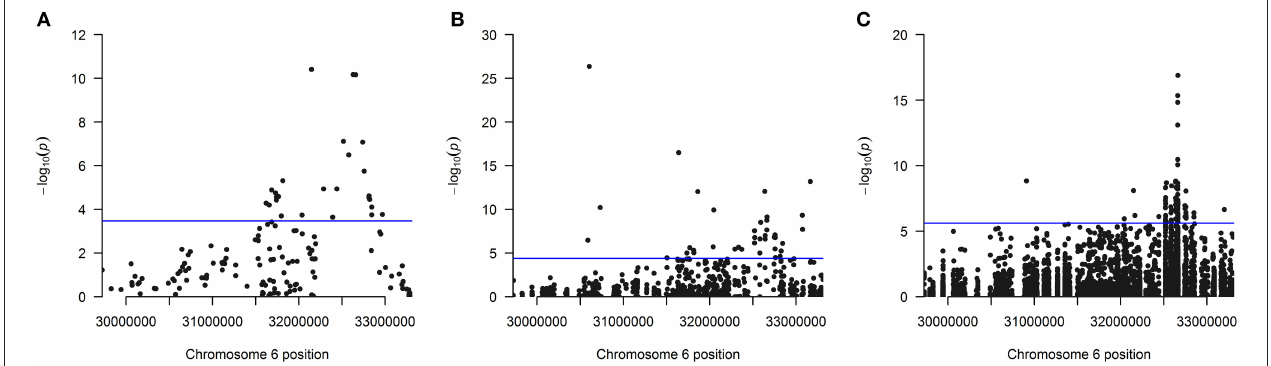
FIGURE 1 | (A) Manhattan plot of all 147 analyzed genes showing the position of the 26 genes found significantly associated after Bonferroni correction using the linear kernel SKAT test (see also Table 1 ). (B) Manhattan plot for all 1,209 analyzed exons showing the position of the 40 exons found significantly associated after Bonferroni correction using the linear kernel SKAT test (see also Table 2 ). (C) Manhattan plot for all 20,236 analyzed SNVs showing the position of the 92 SNVs found significantly associated after Bonferroni correction using logistic regression (see also Supplementary Table 6 ). The line indicates the significance cutoff after Bonferroni correction that is (A) [–log (0.05/147) = 3.47], (B) [–log (0.05/1209) = 4.38] and (C) [–log (0.05/20236) = 5.61]. A circle is drawn for every SNV or at every gene’s or exon’s start position.